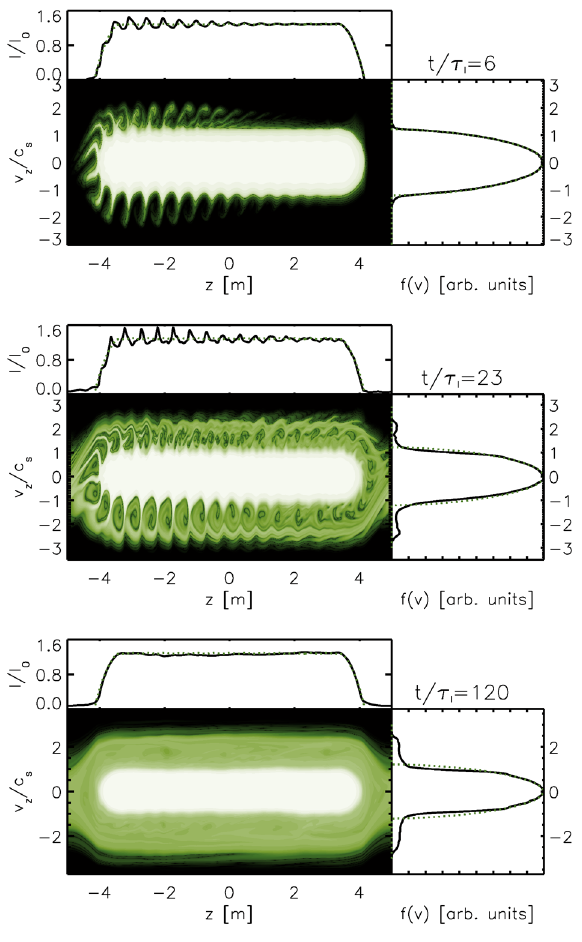
FIG. 11. (Color) Time evolution of the microwave instability in a barrier bucket for U (cid:4) 1 : 0 , V (cid:4) 0 : 2 , and n resolution of the low density phase space regions the contours of ln (cid:1) 1 (cid:2) f (cid:5) are shown and a different color set is used. The green dotted curves represent the initial current profile and velocity distribution.